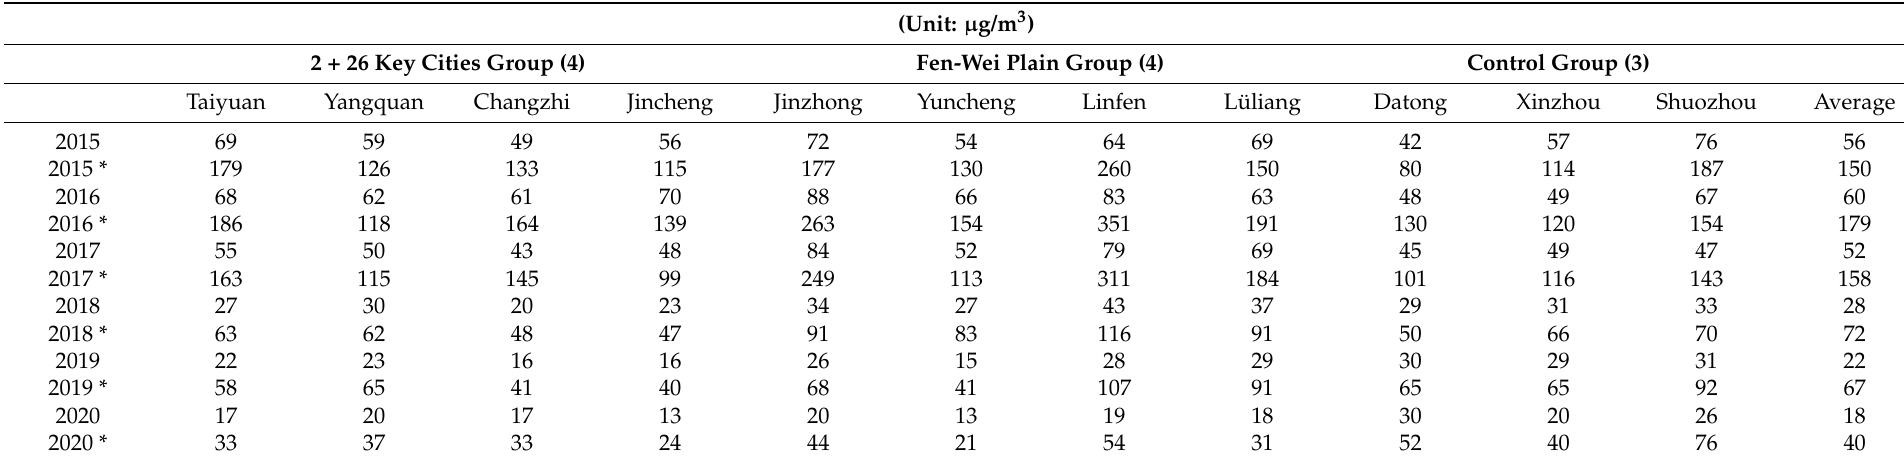
Table 5. The annual mean and maximum monthly concentrations of SO 2 in Shanxi province.